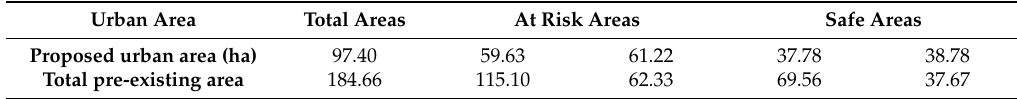
Table 5. Proposed urban area as divided into at risk areas and safe